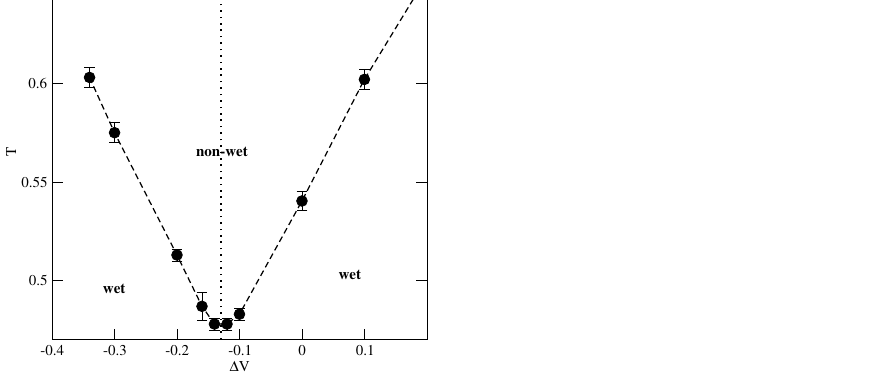
Figure 13. The estimated changes of the dewetting transition temperature with ∆ V , for the systems with u AB = 0, u BB = − 0.8 and ¯ V = −